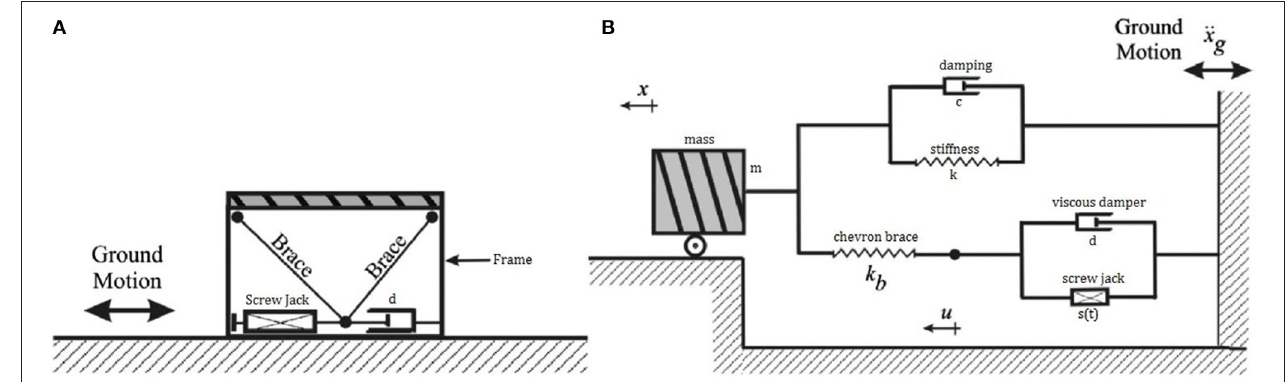
FIGURE 2 | (A) Schematic representation of screw jack-SDOF braced system, and (B) mechanical representation of the